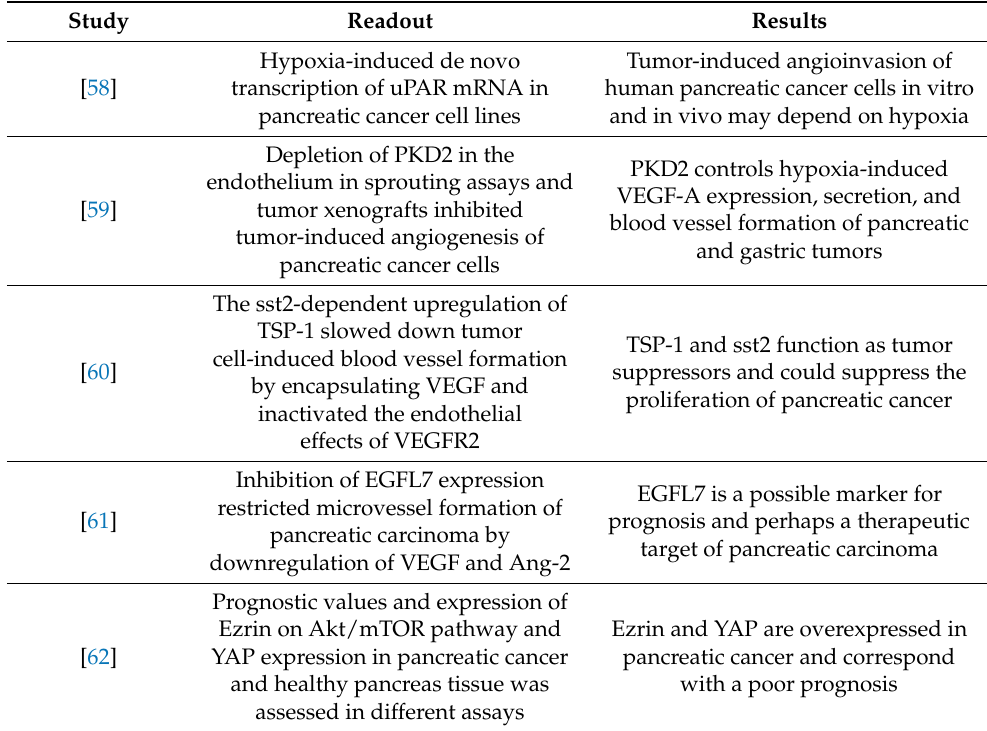
Table 2. Summary of the aforementioned studies that assessed the use of the CAM model for the assessment of tumor-induced angiogenesis in pancreatic